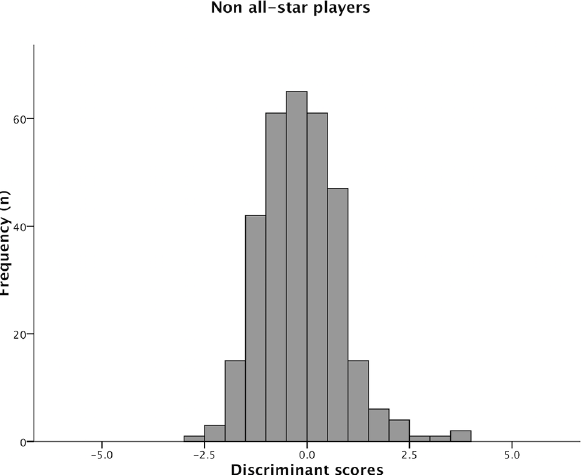
Fig 2. Distribution from the discriminant scores across non all-star